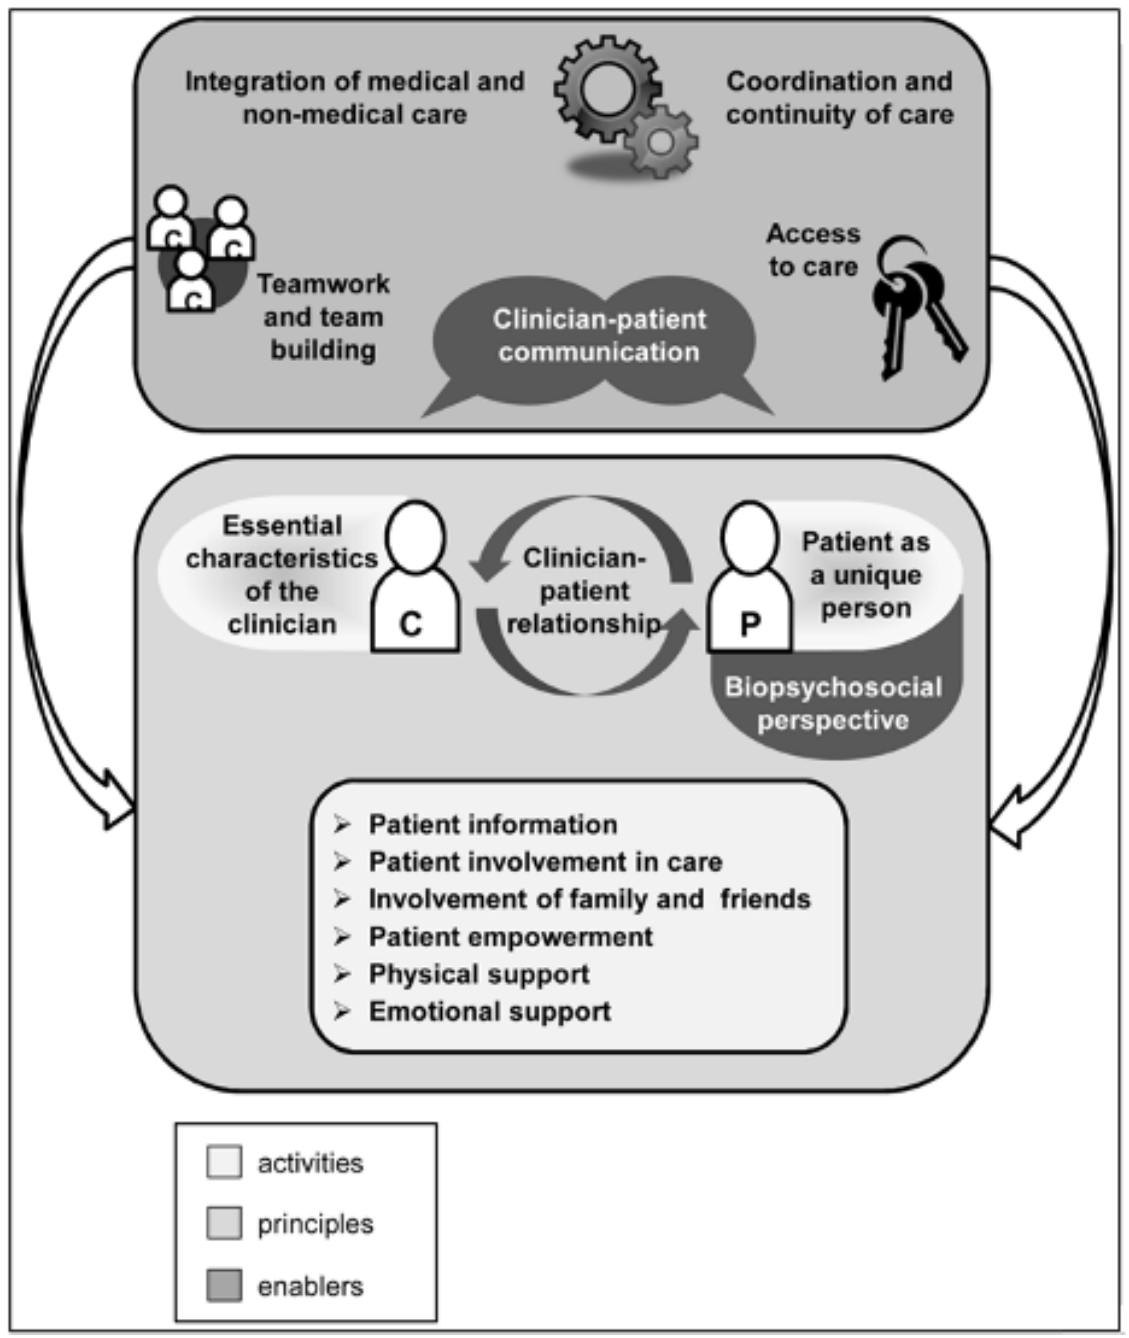
Figure 2. Model of Patient-centered Care, by Scholl et al